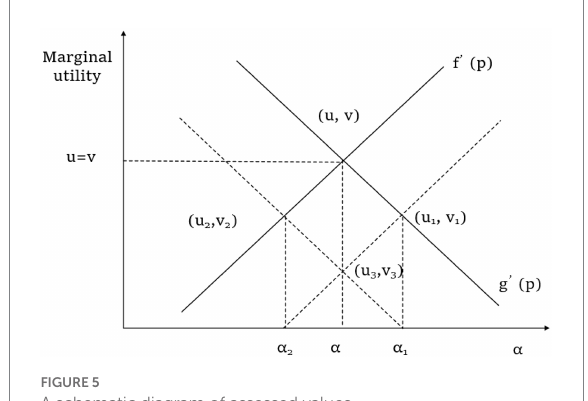
FIGURE 5 A schematic diagram of assessed values.